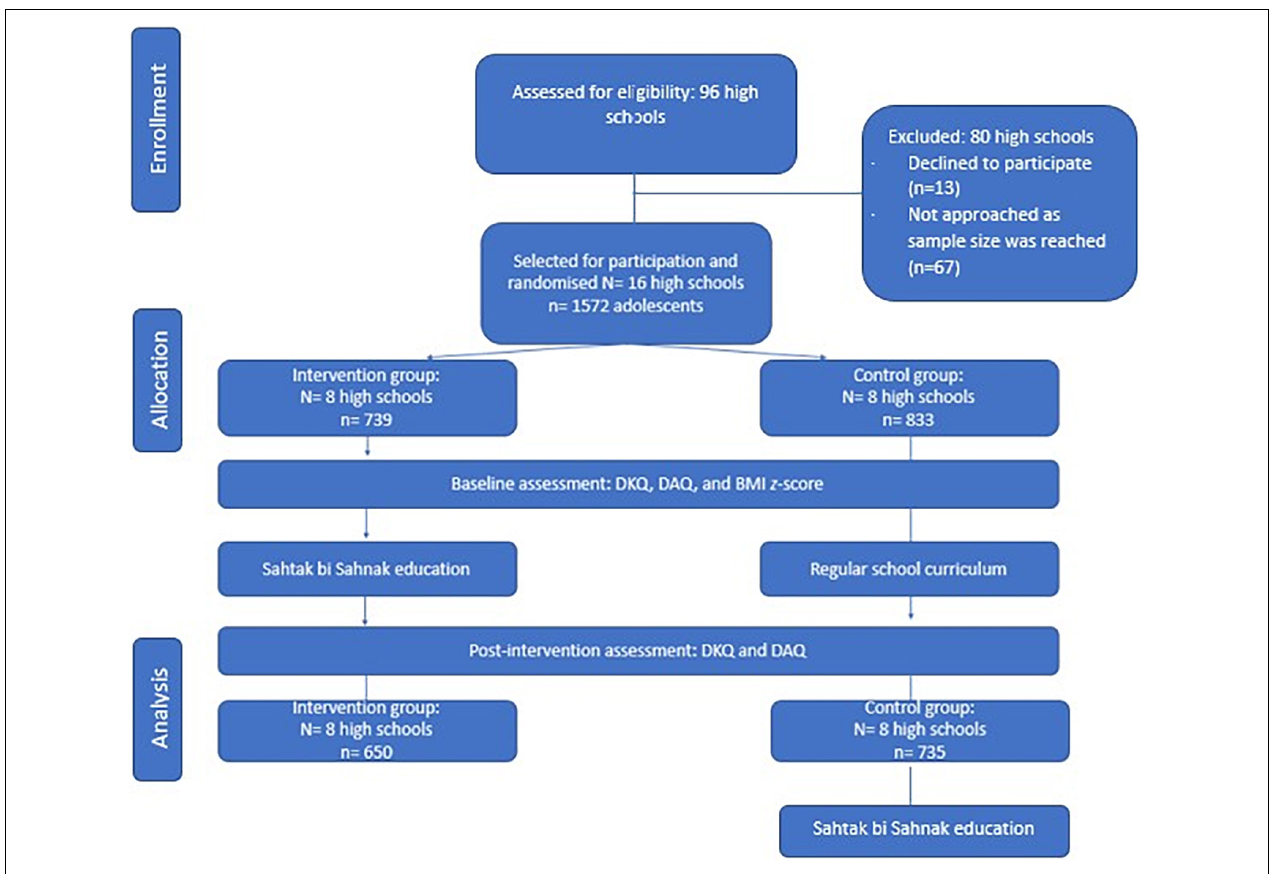
FIGURE 1 | Flow chart of the study design. DKQ, Dietary Knowledge Questionnaire; DAQ: Dietary Adherence Questionnaire; BMI: body mass